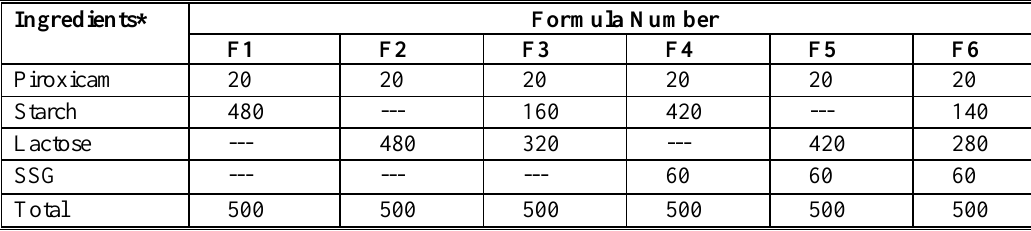
Table 1: Composition of piroxicam capsules